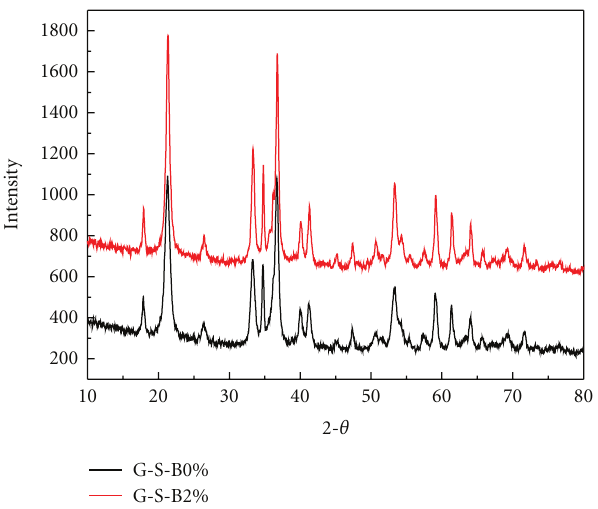
Figure 2: X-ray di ff raction patterns of hematite and B-doped hematite.